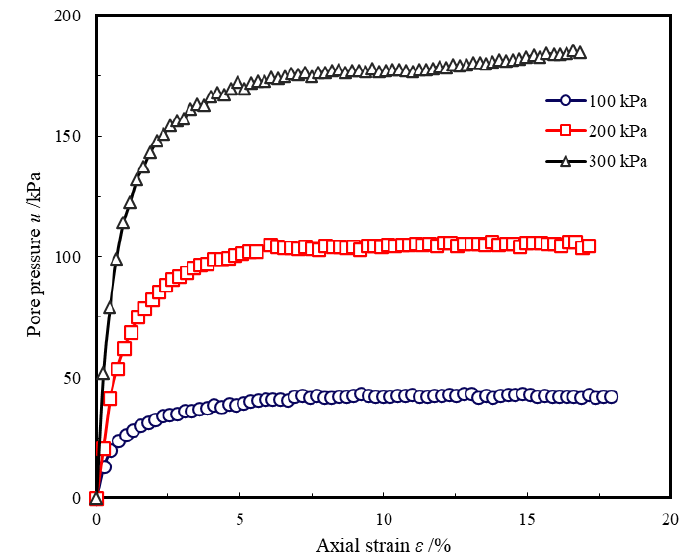
Figure 10. Pore pressure-strain curves in CU